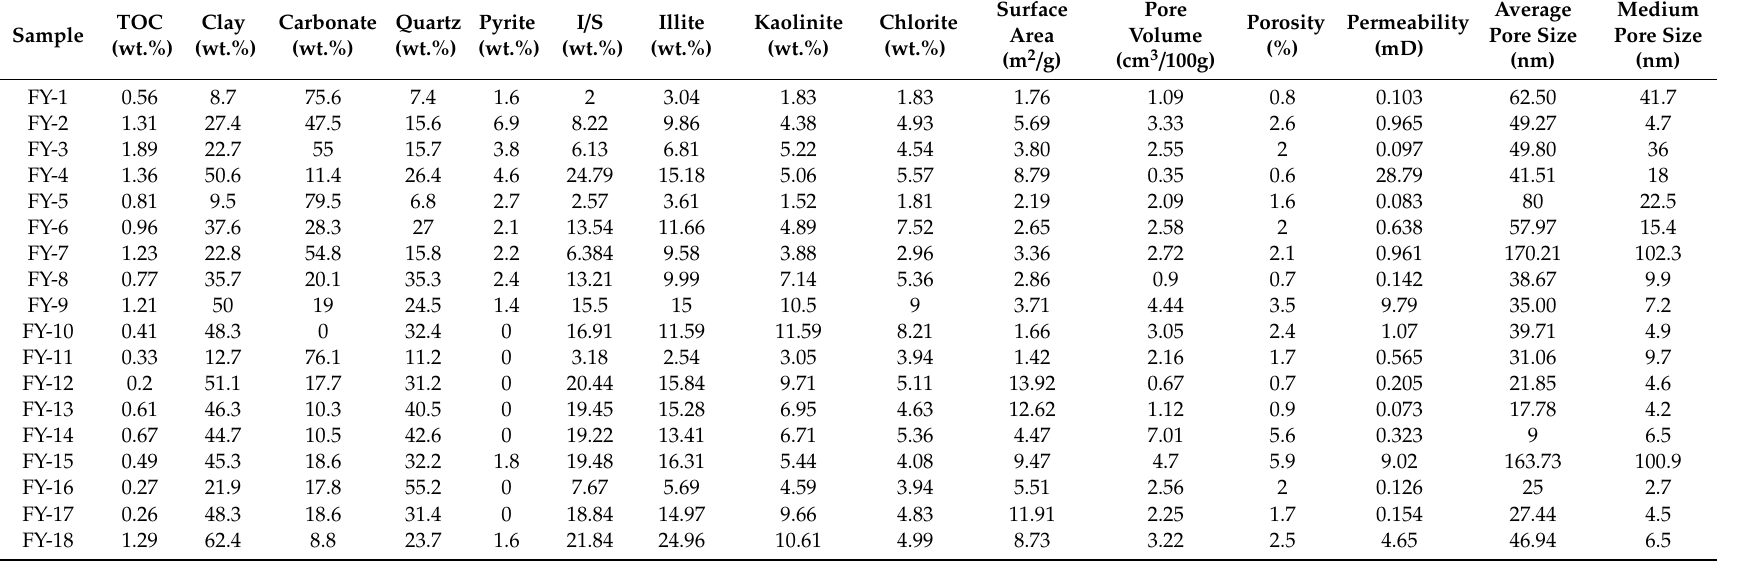
Table 1. The mineral composition and pore structure characteristics of shale